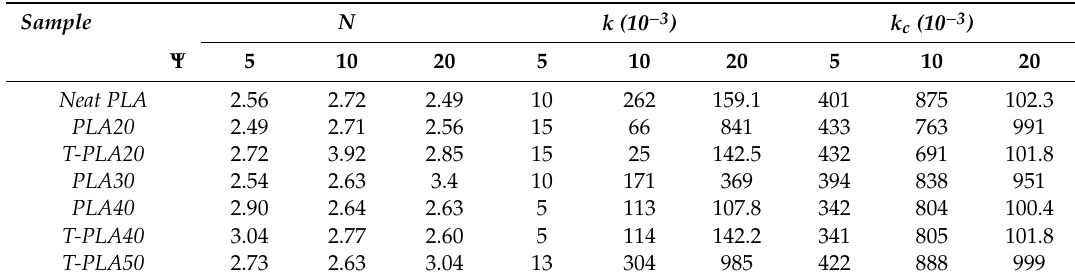
Table 3. Avrami parameters for each of the cooling rates.